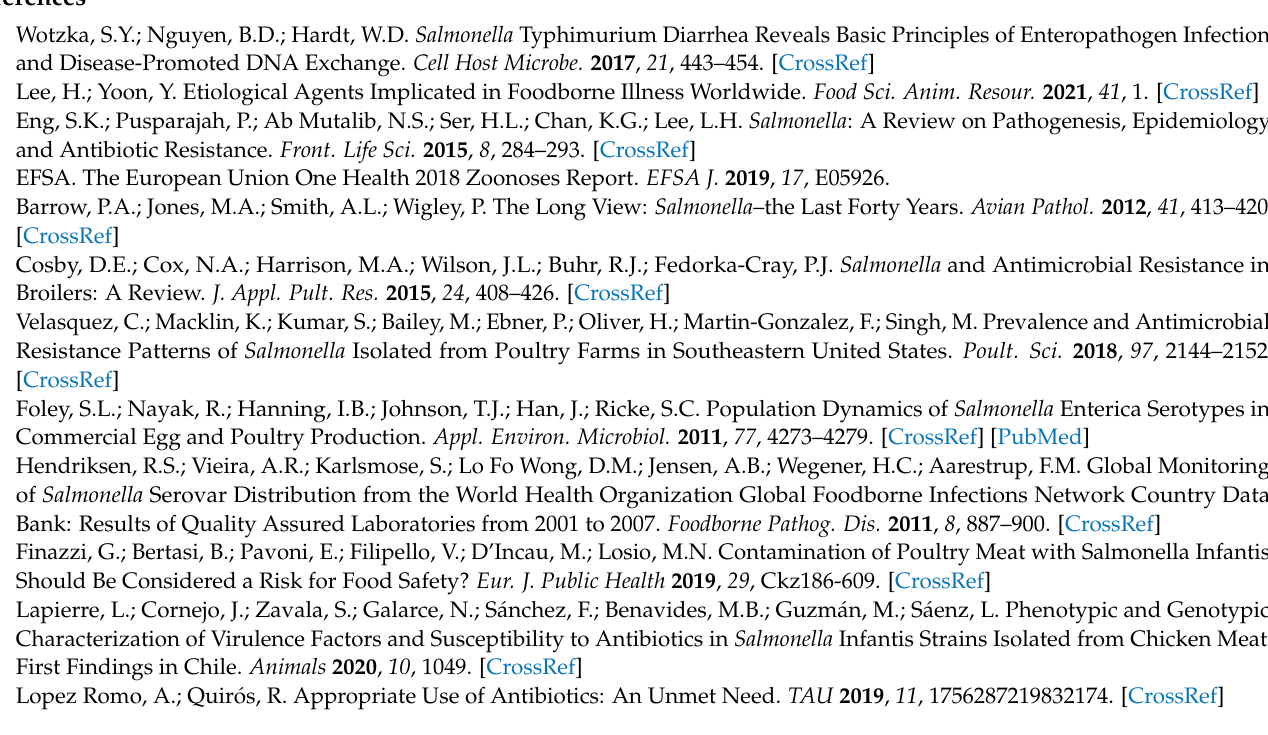
Table S4: Identified prophage sequences in the 29 S . Infantis genomes, Table S5: Virulence genes and factors identified in the 29 S . Infantis genomes, Table S6: Cas genes and CRISPR arrays found in the 29 S . Infantis